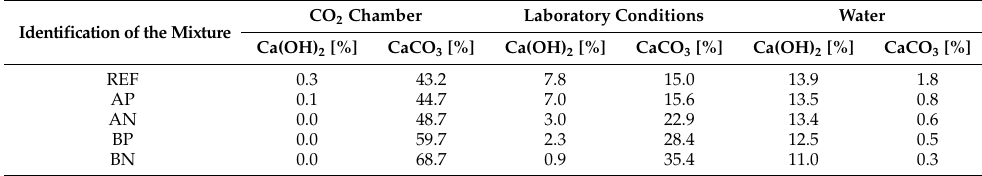
Table 4. Results of DTA analysis of samples from to various